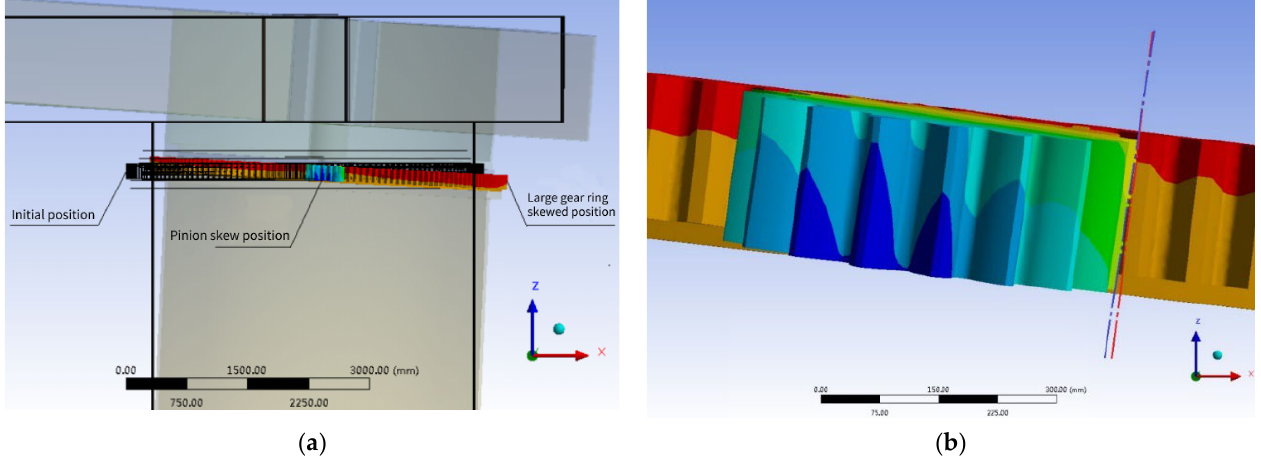
Figure 14. ( a ) Deflection of pinion and large gear ring; ( b ) edge clamping angle of pinion and large gear ring tooth width.